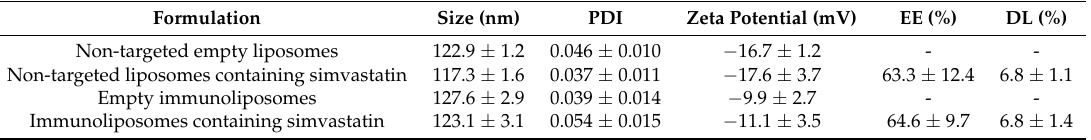
Table 3. Properties of liposome formulations. Average size, polydispersity index (PDI) and zeta potential of